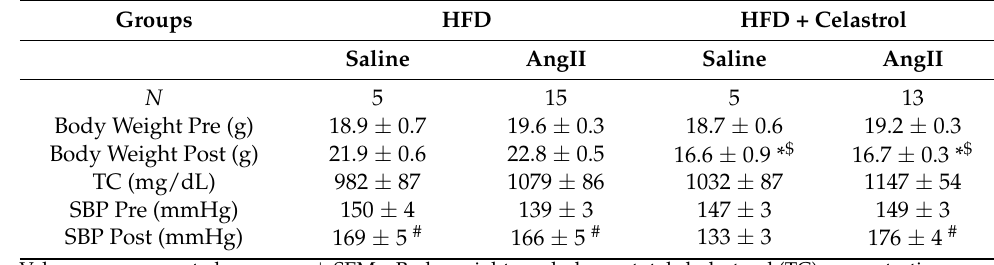
Figure 2. ( A ) Abdominal aortic luminal diameters were measured by ultrasound on weeks 0 and 4 of saline or AngII (500 ng/kg/min) infusion in male mice (saline n = 5; AngII n = 11). Purple (saline + HFD), teal (saline + HFD + Cel), blue (AngII + HFD), and red (AngII + HFD + Cel) circles represent means, and bars are SEMs. * Denotes p < 0.05 when comparing saline vs. AngII infusion; # p < 0.05 AngII + HFD vs. AngII + HFD + Cel (two-way ANOVA repeated measures test). ( B ) Ultra- sound pictographs of suprarenal aortas of individual mice at week 4 nearest to the mean of the group. ( C ) Measurements of maximal external width of abdominal aortas. * Denotes p < 0.001 saline vs. AngII infusion; # p < 0.001 AngII + HFD vs. AngII + HFD + Cel (two-way ANOVA with Holm–Sidak post hoc analysis). ( D ) Representative images of abdominal aortas nearest the mean of each group. ( E ) The incidence of AAA. # p < 0.001 AngII + HFD vs. AngII + HFD + Cel (Fisher’s exact test). ( F ) Area of ascending aortic arch and atherosclerotic lesion area ( G ) was measured on the intimal surface of the aortic arch. * Denotes p < 0.05 when comparing saline vs. AngII infusion; # p < 0.05 AngII + HFD vs. AngII + HFD + Cel (two-way ANOVA with Holm–Sidak post hoc analysis). ( H ) Representative images of ascending aortas nearest the mean of each group. AngII: angiotensin II, HFD: high-fat diet, Cel: Celastrol. Table 3. Effects of Celastrol in female Ldl receptor -/- mice infused with saline or high dose of AngII (1000 ng/kg/min).